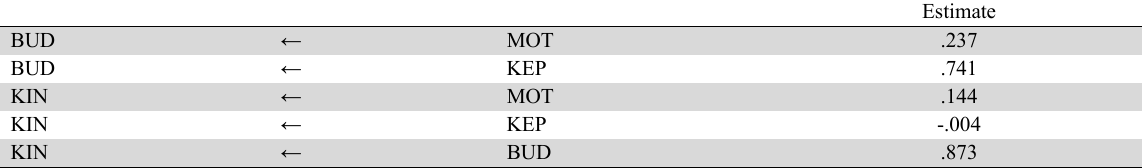
Standardized Regression Weight of Work Motivation (MOT), Leadership (KEP), Cultural Organiza- tion (BUD) and Performance (KIN)